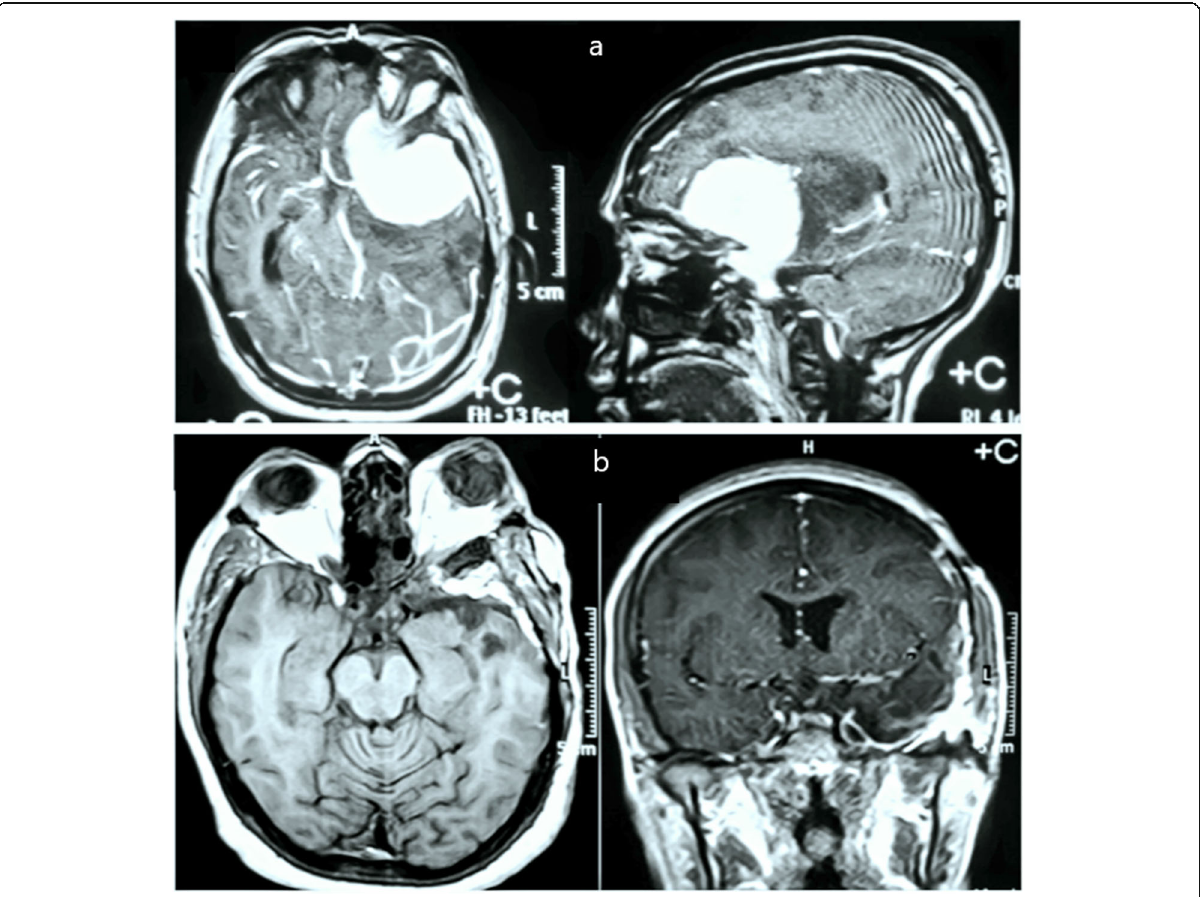
Fig. 4 a , b Preoperative and postoperative imaging of case 2 with left ACM (type II). a Preoperative MRI with enhancement axial and sagittal view showing the displacement of the ICA bifurcation. b Postoperative MRI T1-weighted non-enhanced axial view and T1-weighted coronal view after contrast showing gross total resection and a hyperintense signal at the temporal pole explained by the fat and fascia lata graft used for the dura and the skull base